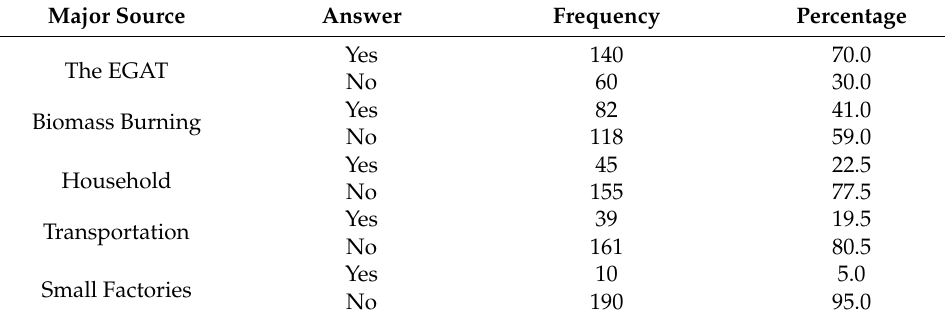
Table 6. Perceived major sources of atmospheric pollution in Mae Moh ( n =